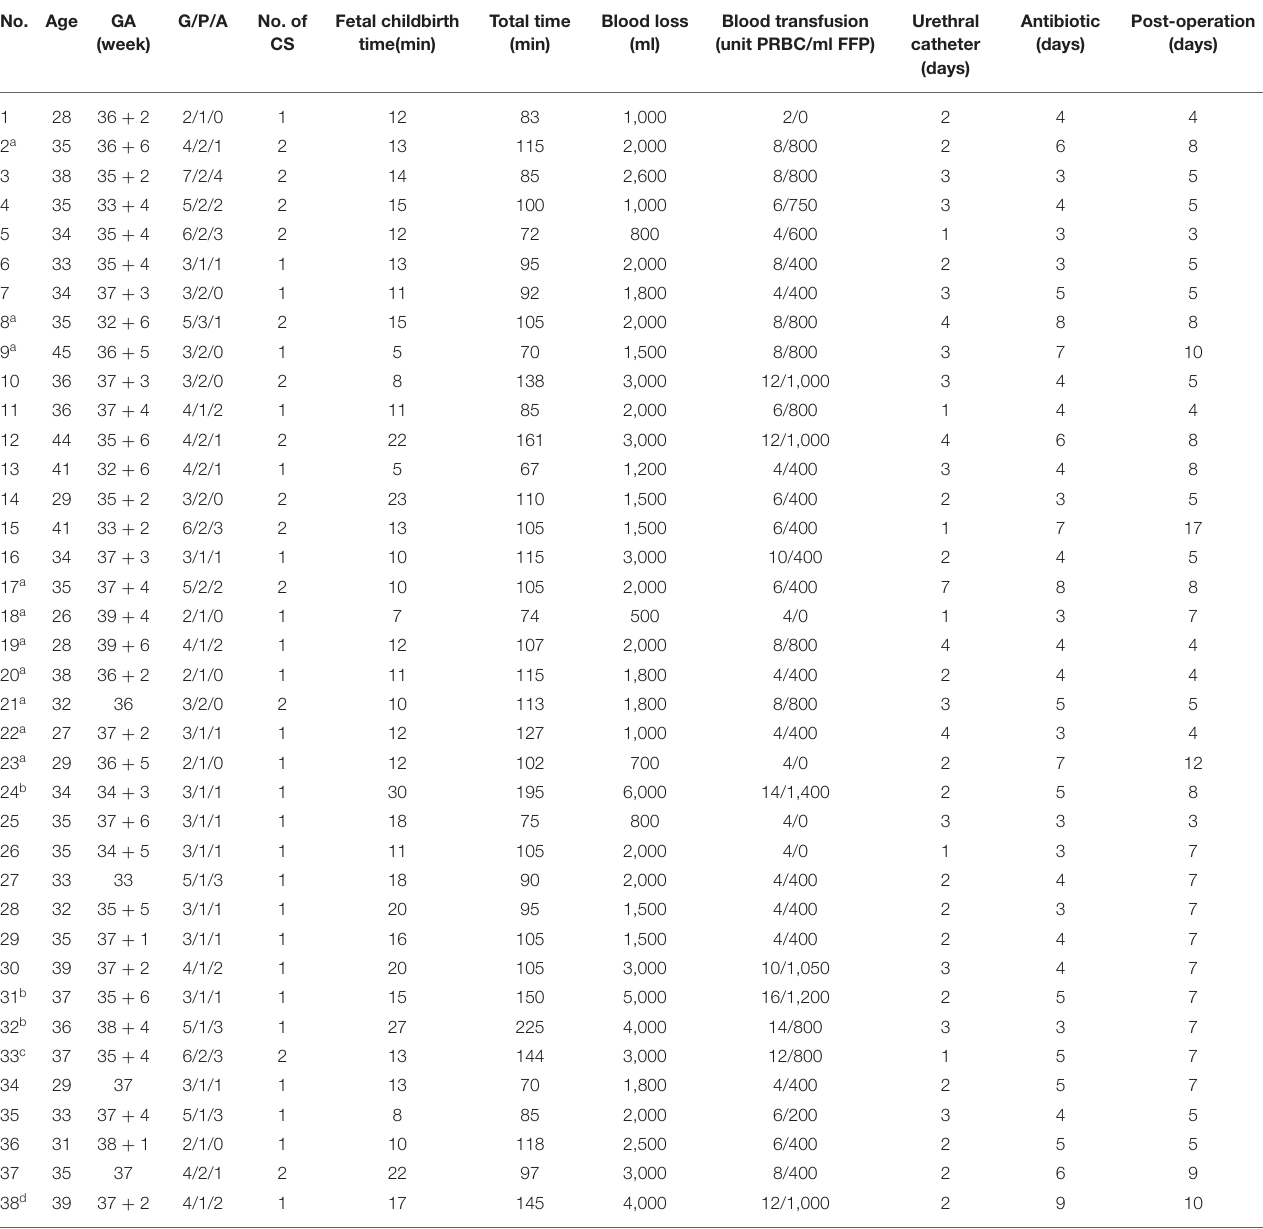
TABLE 2 | Clinical characteristics of study